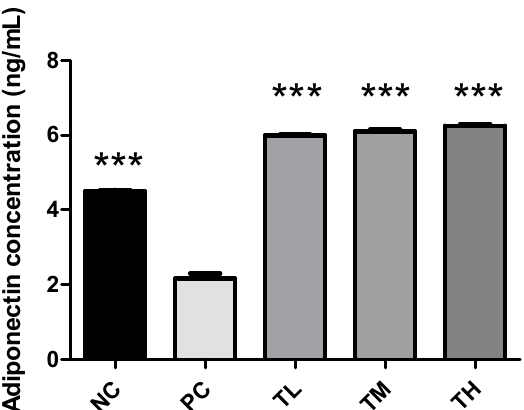
Figure 2. Effect of IMD on secretion of adiponectin in plasma of mice with LPS-induced chronic inflammation. Results are expressed as means ± SEM of n = 4 samples for NC and PC, and n = 6 samples for TL, TM, and TH. Differences in means were considered statistically significant for *** p < 0.001 relative to PC.